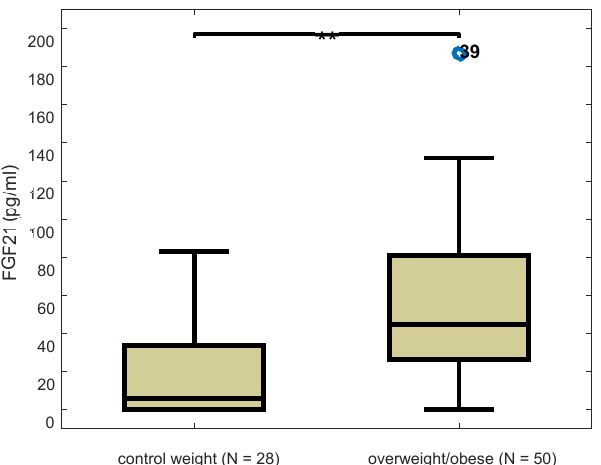
Figure 1. Boxplot distributions of serum FGF21 levels in control and overweight/obese participants (z = − 3.725, p < 0.001), Mann-Whitney test. Blue dot indicates outlier value and double asterisk ** significance at 0.01 level.